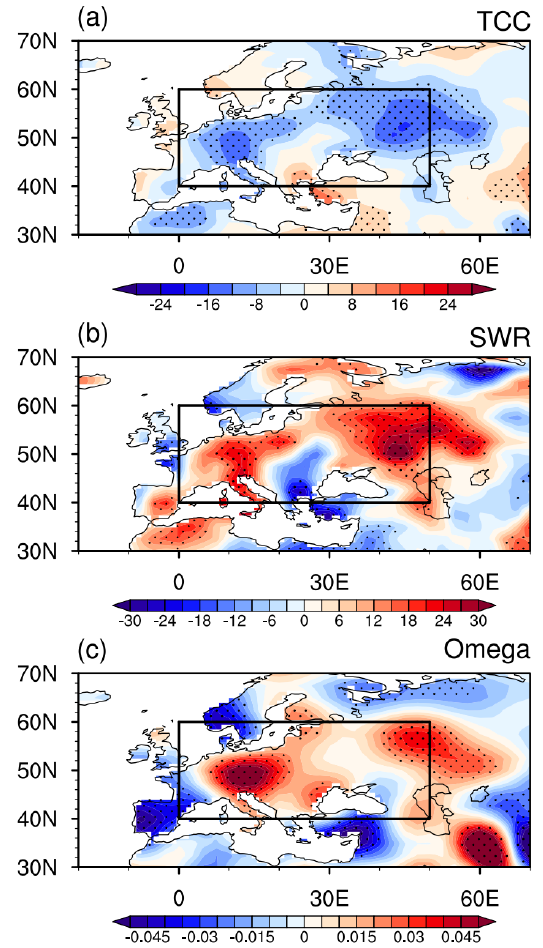
Figure 3. Anomalies of ( a ) total cloud cover (TCC) (unit: %), ( b ) short wave radiation (SWR) (unit: W m 2 ) and ( c ) 500-hPa omega (i.e., the vertical velocity under pressure coordinates) (unit: Pa · s − 1 ) in June of 2019 relative to 1948–2019. Stippling regions in ( a – c ) represent TCC, SWR, and omega anomalies exceeding one standard deviation from 1948 to 2019, respectively.